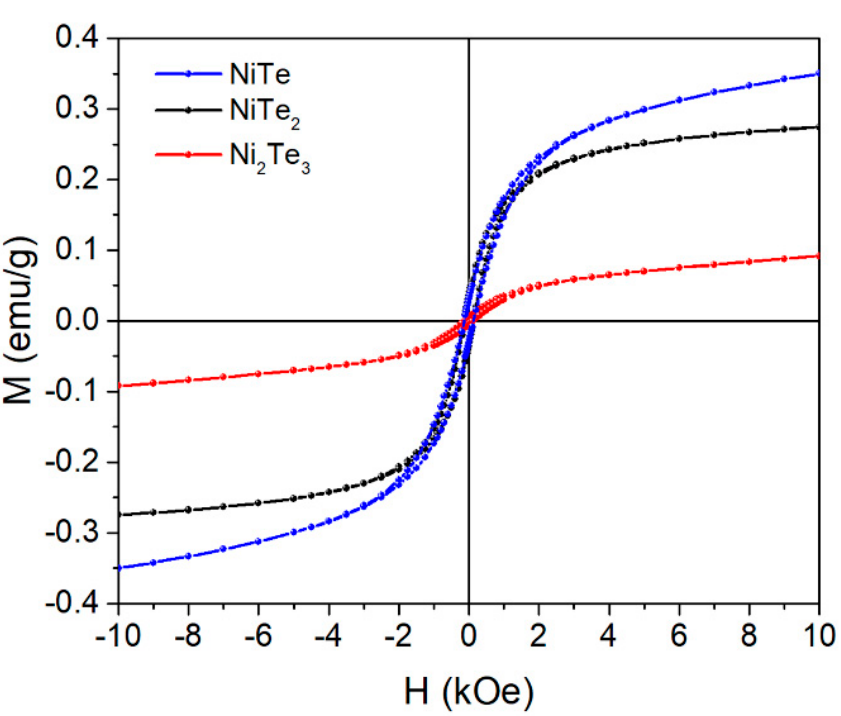
Figure 7. Room-temperature magnetization curves for NiTe after 8 h milling time, NiTe 2 after 12 h milling time, and Ni 2 Te 3 after 12 h milling time. The line serves as a guide to the eye. The UV-VIS spectra of nickel tellurides are presented in Figure 8. From those data, optical band gap energies were determined using Tauc plots and the equation: ( α h ν ) n = A ( h ν − E g ) Here, α is the absorption coefficient (cm − 1 ), h ν is the photon energy (eV), A is a constant, and n = 2 for a direct transition. By plotting ( α h ν ) 2 vs. ( h ν ) and extrapolating the linear portion of the curve to the x -axis, the band gap value E g (eV) can be obtained as the intercept [52]. The band gap energies calculated for NiTe, NiTe 2 , and Ni 2 Te 3 and are 3.59, 3.94, and 3.70 eV, respectively. The value obtained for NiTe is in very good agreement with the result 3.56 ± 0.01 eV reported in the literature [7] for nanosized NiTe prepared by the reduction method. The results are of considerable interest in the view of further applications of mechanochemically prepared nickel tellurides. One particularly promising area seems to be the use of nickel tellurides as photo-electrocatalysts and photocatalysts gap